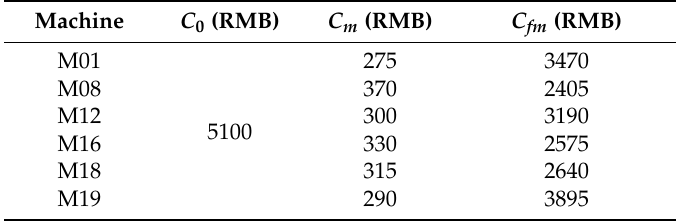
Table 6. The maintenance cost data of each secondary critical